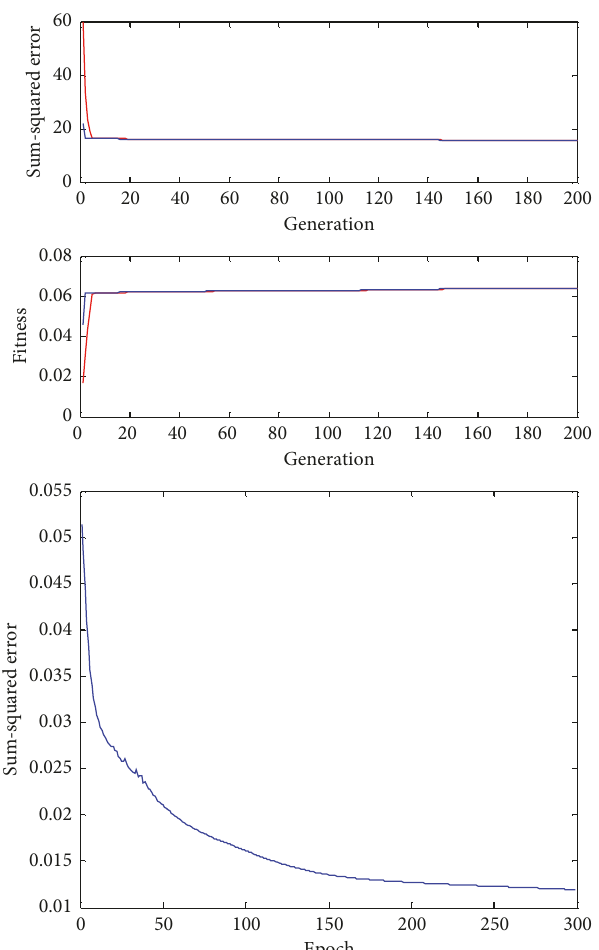
Figure 3: Training performance of the FWNN based on hybrid GA-GDA